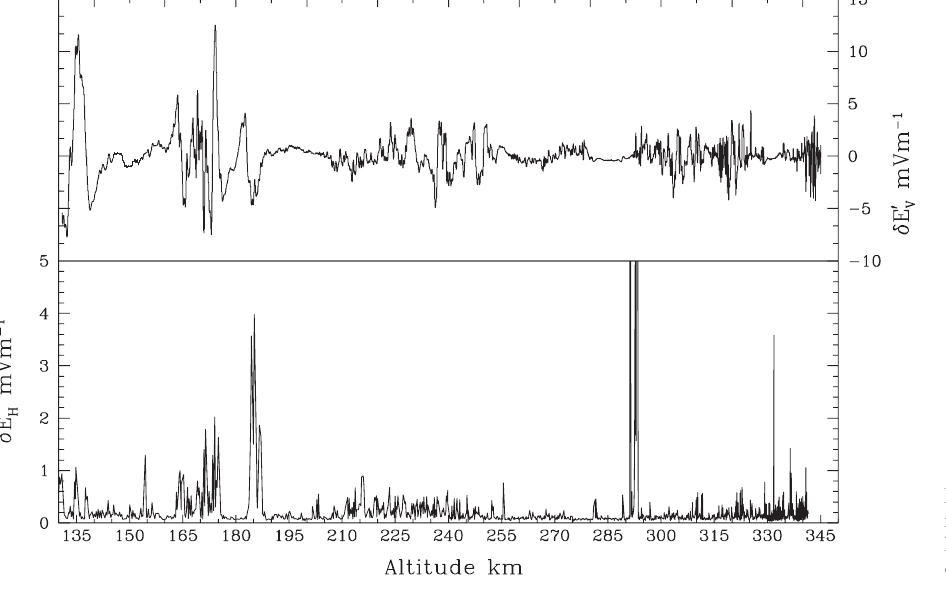
Fig. 4. Electric field fluctuations in the vertical ( upper panel ) and horizontal ( lower panel ) directions observed